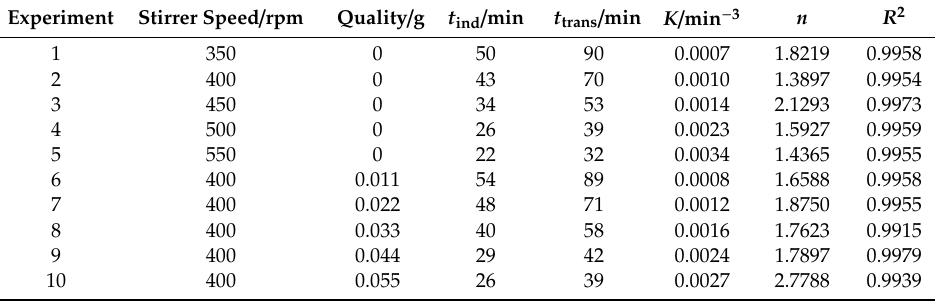
Table 1. Kinetics parameters of the co-crystallization process of experiments